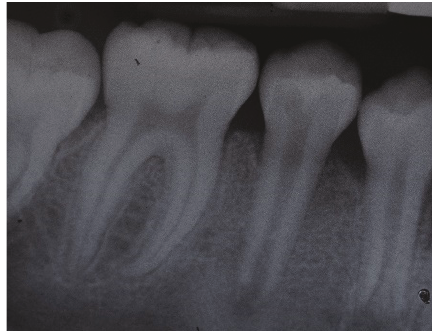
Figure 2: Periapical radiograph of tooth 45 showing immature root apex.